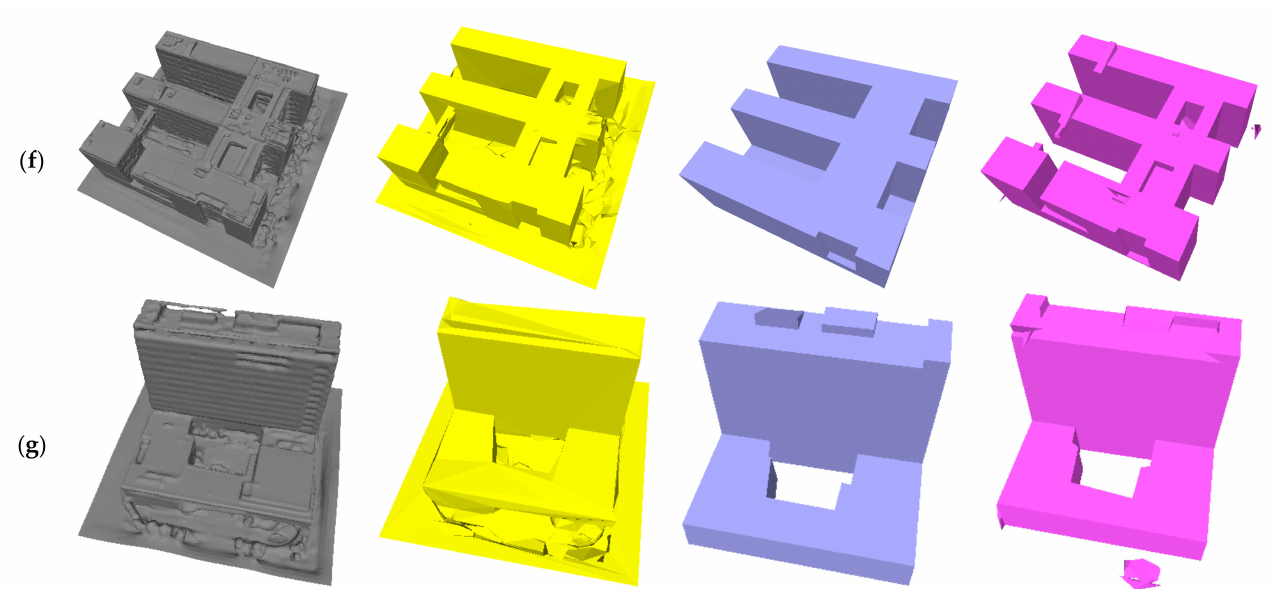
Figure 9. ( a – g ) Polyhedral results of different building mesh models. From left to right: the original mesh models, the results of VSA [17], the results of SABMP [19], and our results.